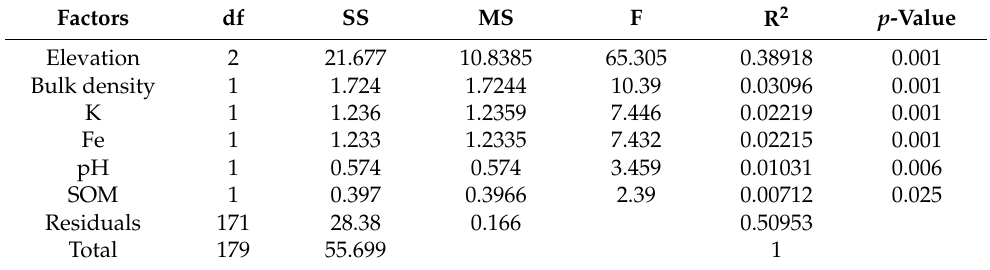
Table 4. Results of PERMANOVA analysis of species composition of biological soil crust by elevation and soil factors of the EMS of southern Ecuador. df = degrees of freedom; SS = sum of squares; MS = median squares, F = F-statistics; R 2 = coefficient of variation.